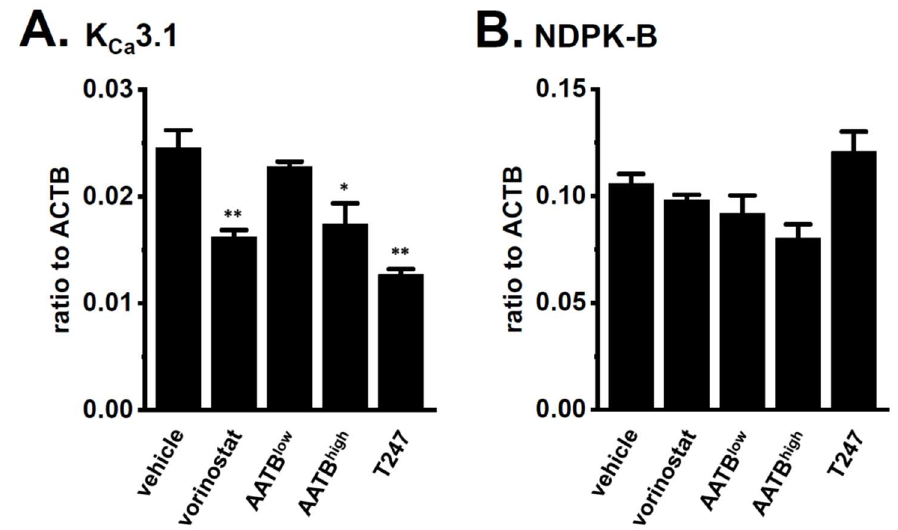
Figure 6. Effects of a treatment with HDACis for 24 h on the gene expression of K Ca 3.1 and NDPK-B in mouse thymocytes stimulated by concanavalin A (5 μg/mL). ( A , B ) Real-time PCR assay for K Ca 3.1 ( A ) and NDPK-B ( B ) in “vehicle”-, 1 μM “vorinostat”-, 30 nM AATB (“AATB low ”)-, 300 nM AATB (“AATB high ”)-, and 1 μM “T247”-treated mouse thymocytes ( n = 4 for each). Expression levels were expressed as a ratio to ACTB. The results are expressed as means ± SEM. *, **: p < 0.05, 0.01 vs. vehicle control.